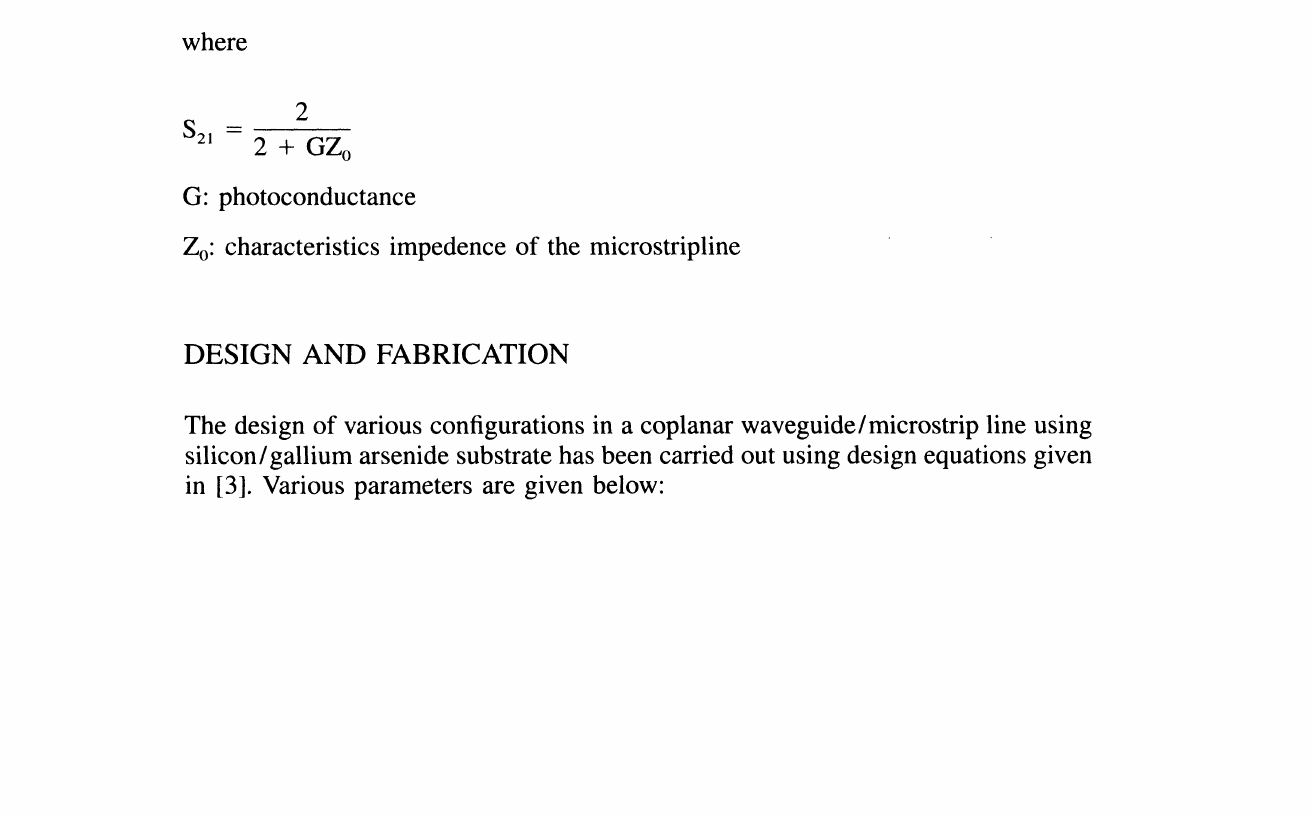
FIGURE 3B Attenuation vs power/area